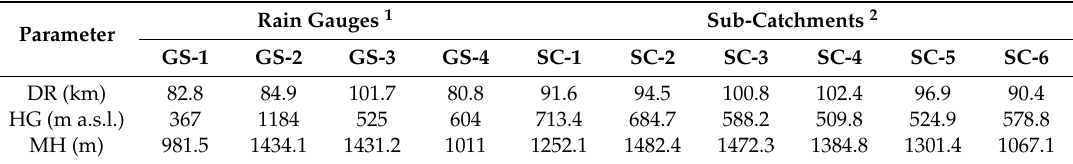
Table 5. Adjusted parameters for rain gauges and sub-catchments.